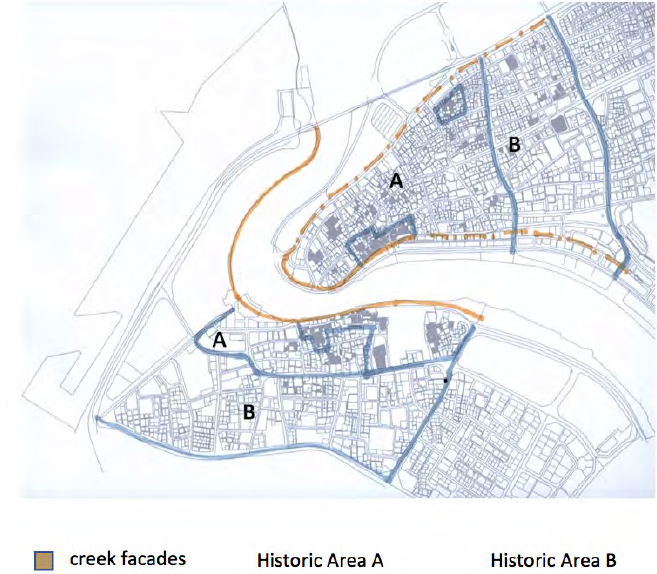
Figure 2. Dubai’s Historical District divided areas (Documentations form AHAD)